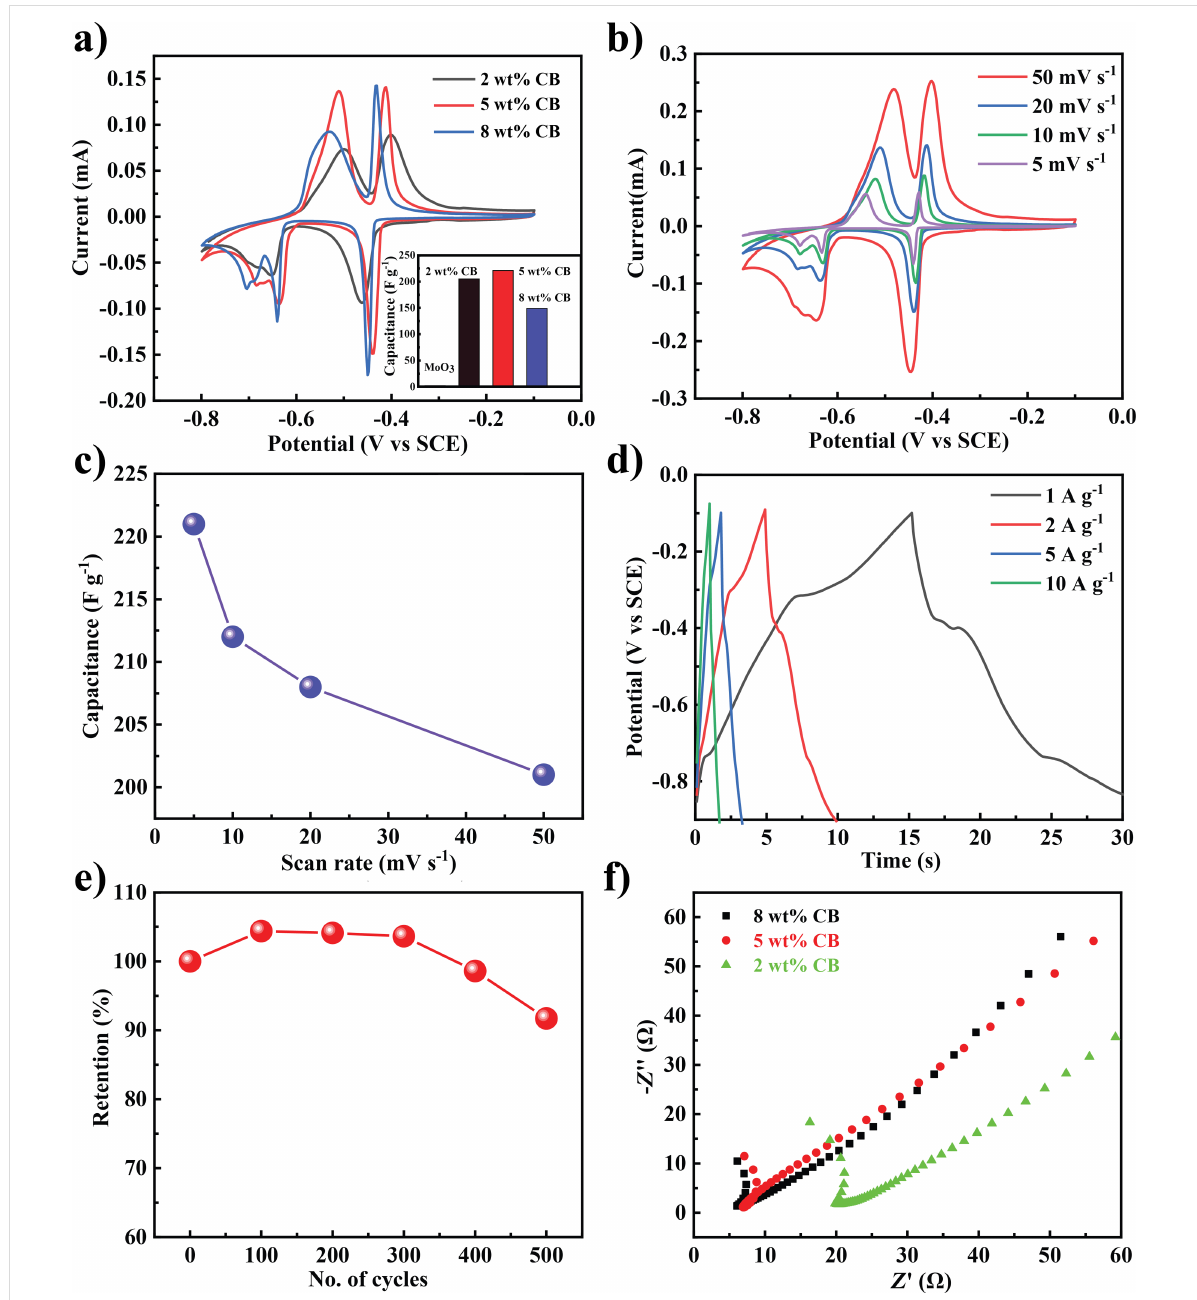
Figure 3: (a) CV measurement of MoO 3 /carbon black composites showing pseudo capacitive behavior, inset shows the change in capacitance with increasing mass fraction of carbon black; (b) performance of a composite electrode with 5 wt % CB as a function of the changing scan rate; (c) capaci- tance as a function of the scan rate, (d) galvanostatic charge–discharge profile of the 5 wt % CB composite; (e) capacitance retention of the 5 wt % CB composite; (f) EIS of the composites.